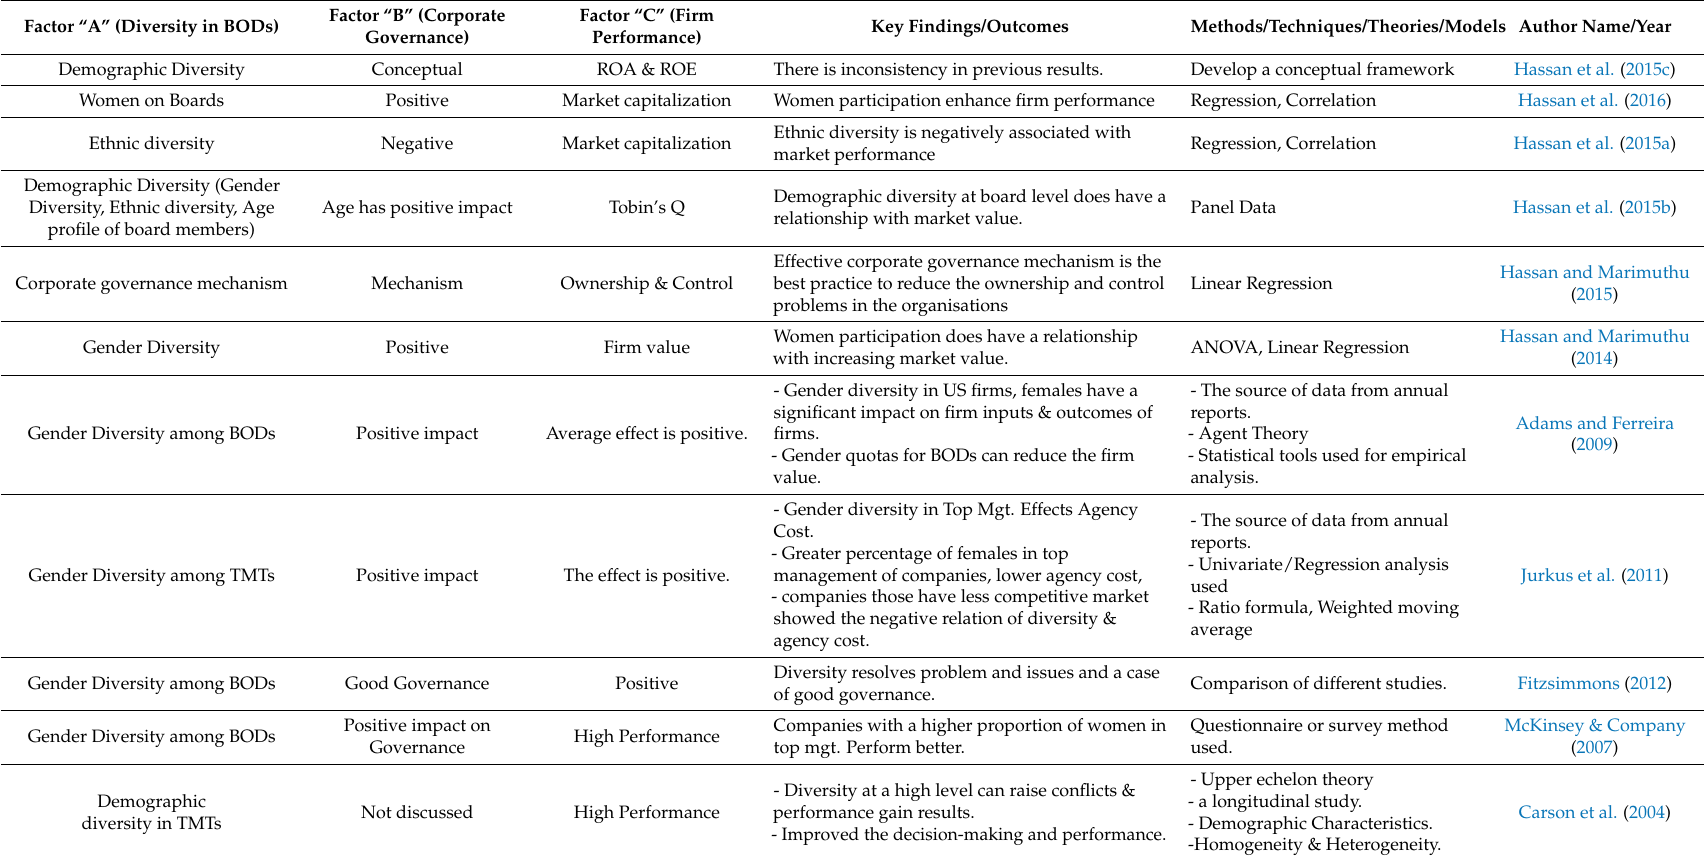
Table A1. Review of research related to diverse corporate boards and firm